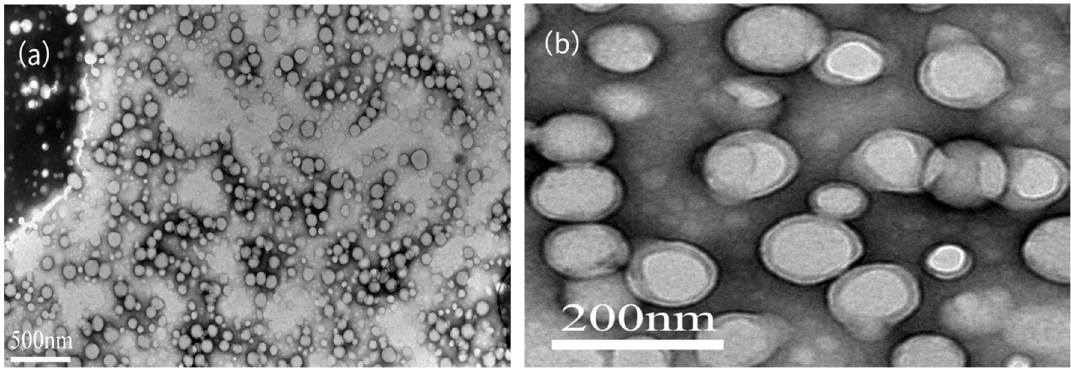
Figure 8. TEM images of emulsion particles with 4% DNS-86: ( a ) 500nm, ( b ) 200nm.